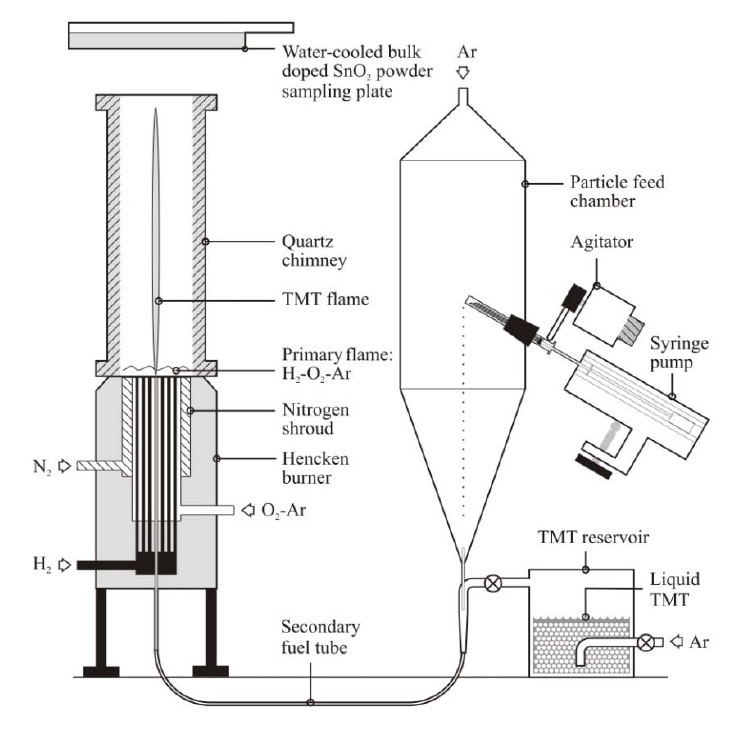
Figure 1. Schematic of the combustion synthesis (CS) facility used to generate the SnO powders and the CS generated Au